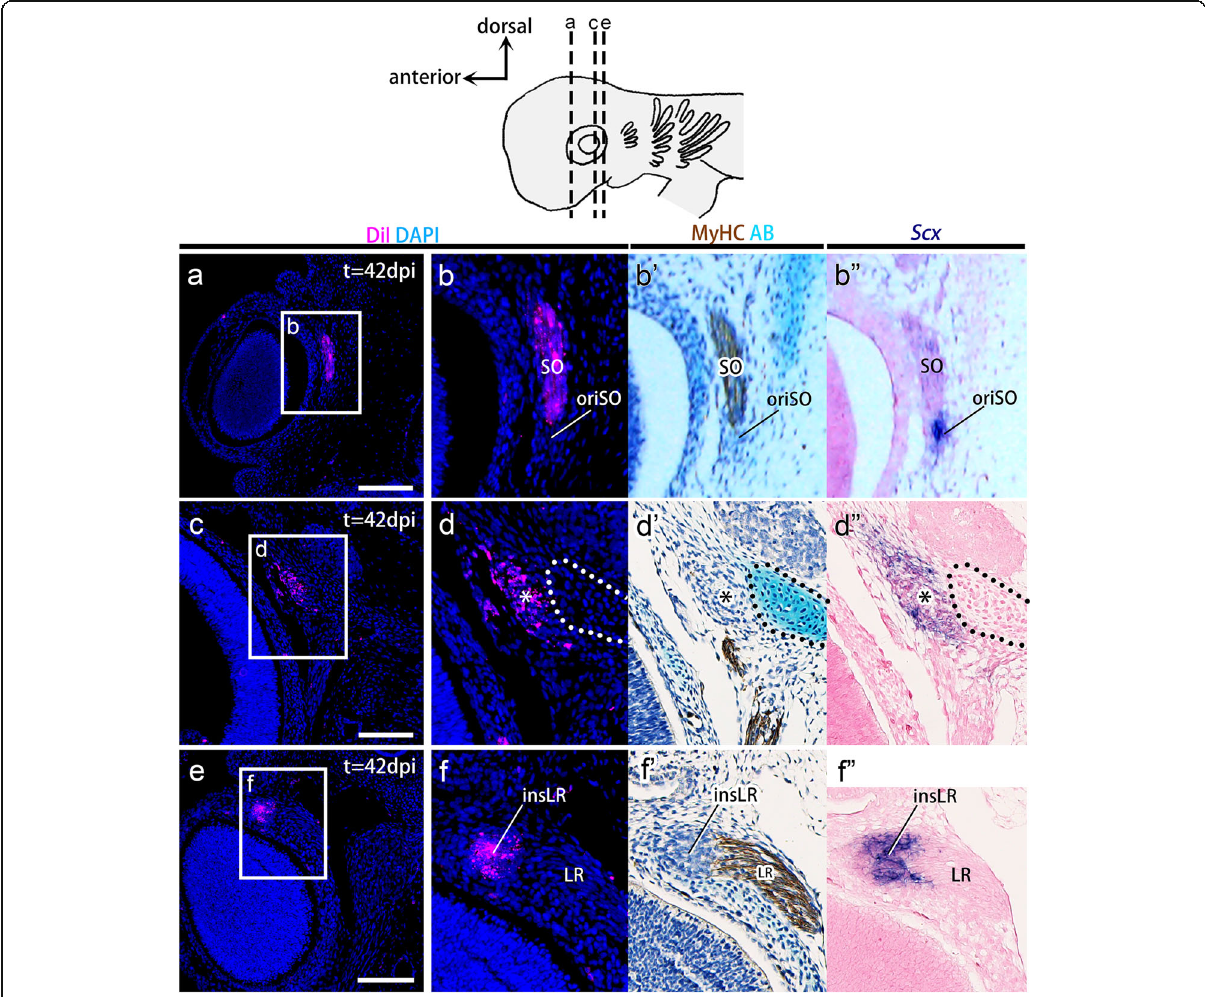
Fig. 5 Lineage tracing of the mandibular head cavities. a-f ″ Transverse sections of CM-DiI-injected embryos aligned with adjacent sections immunostained with myosin heavy chain antibody ( b ′ , d ′ , and f ′ ), stained with Alcian blue (AB) ( b ′ , d ′ , and f ′ ), or hybridized in situ with an Scx antisense probe ( b ″ , d ″ , and f ″ ). By 42 dpi, DiI-labeled cells (magenta) were found in the superior oblique muscle, and the Scx- positive tendon progenitor cells were found at the scaffold of all rectus eye muscles (asterisks) and the insertion site of the lateral rectus muscle (insLR). insLR, tendon progenitor cells at the insertion site of the lateral rectus muscle; LR, lateral rectus muscle; SO, superior oblique muscle. Scale bars = 200 μ